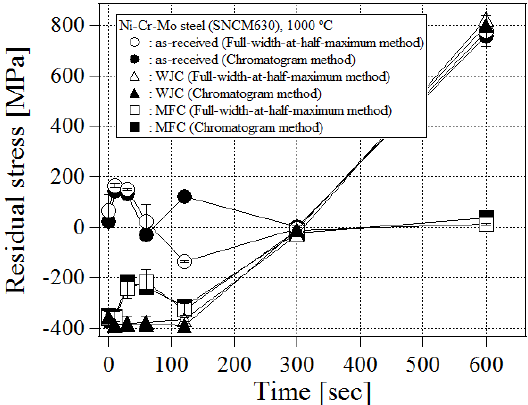
Figure 6. Time dependence of residual stress for SNCM 630 (Ni–Cr–Mo steel).